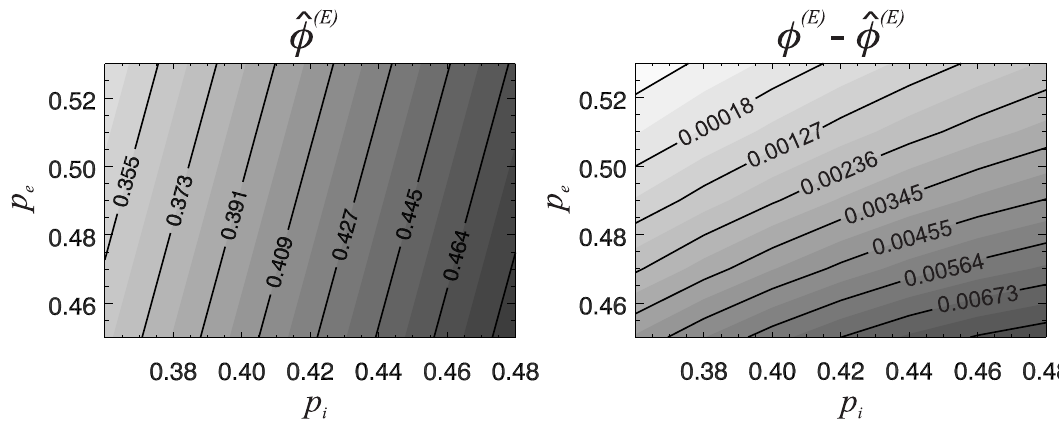
Fig. 17. (a) Fitted plane to estimated for ˆ φ (E) for the constant link and hillslope areas case. (b) Magnitude of the error for φ (E) − ˆ φ (E)